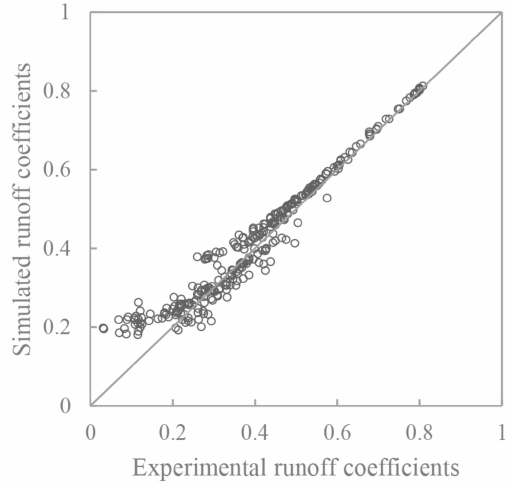
Figure 5. Comparison of sub-basin runoff coefficients between experimental and simulated